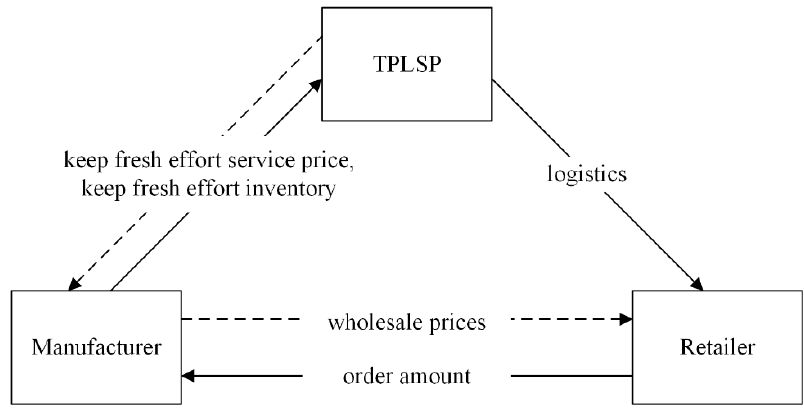
Figure 1. Game sequence of fresh agricultural product supply chain.